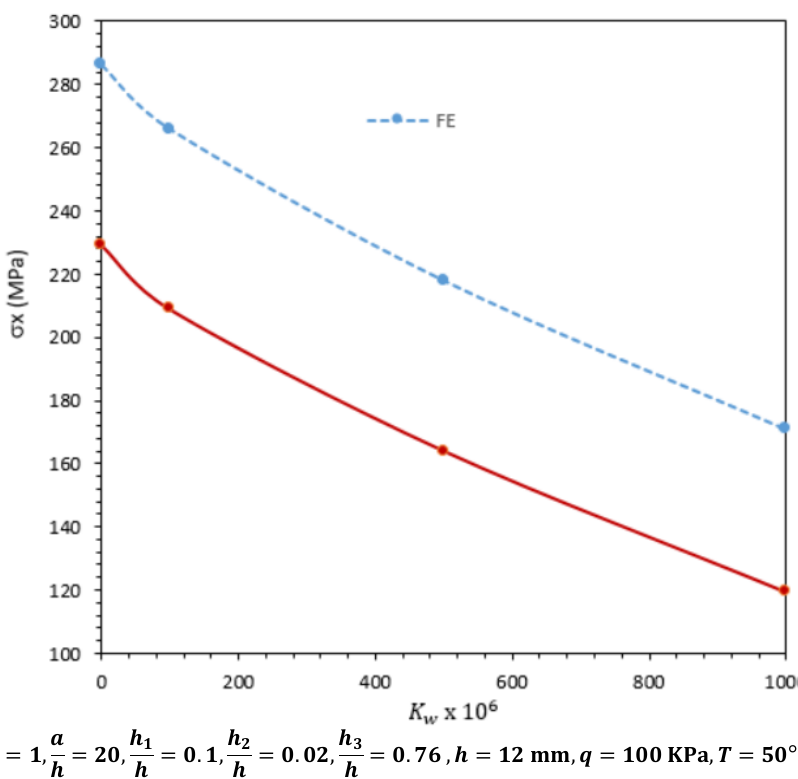
Figure 8. Effect of the elastic foundation on the maximum normal stresses (point 6) of sandwich plate.